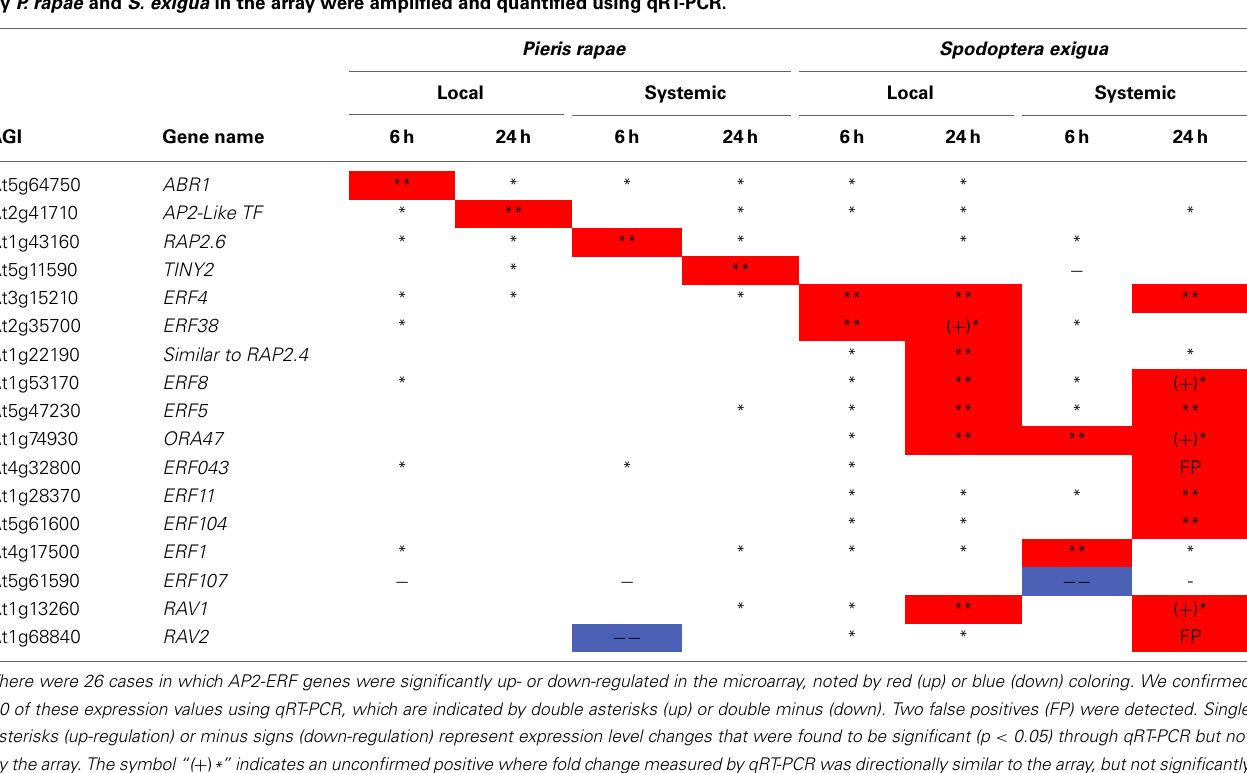
nanoliters/gram fresh weight/minutes of incubation time. Asterisks represent data points that are significantly different than controls as determined by the GLM method in SAS ( p < 0 .